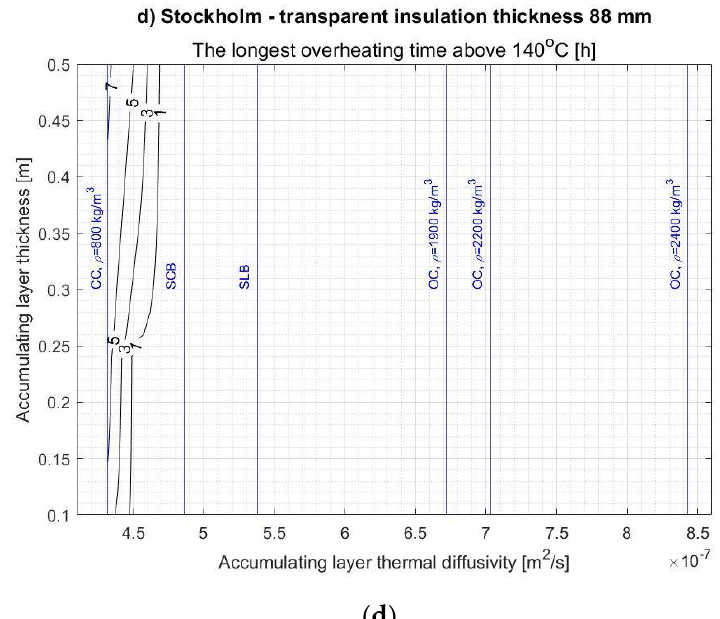
Figure A2. Contour graphs characterizing the SW basic parameters in a function of AL thermal diffusivity and thickness for the whole heating season: ( a ) the heat balance of the SW’s unit area, ( b ) the heating time, ( c ) the mean time lag of the maximum temperature on the absorber and SW’s internal surface during the day, ( d ) the longest overheating time above 140 °C in the TI. TI thickness: 88 mm. Location: Stockholm.